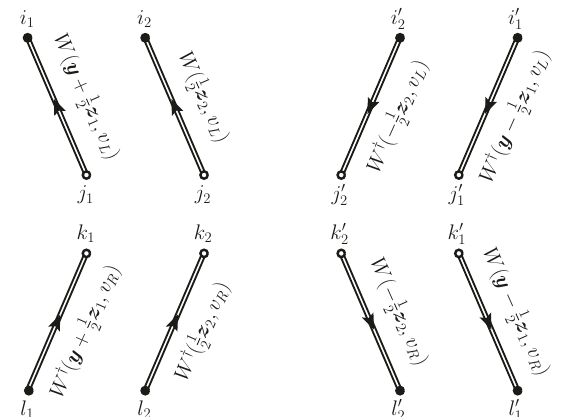
Figure 1. Wilson lines and colour indices of the extended soft factor defined by (3.12) and (3.13). Wilson lines with subscripts 1 are grouped into the operator O S,q ( y , z 1 ) and those with subscripts 2 into the operator O S,q ( 0 , z 2